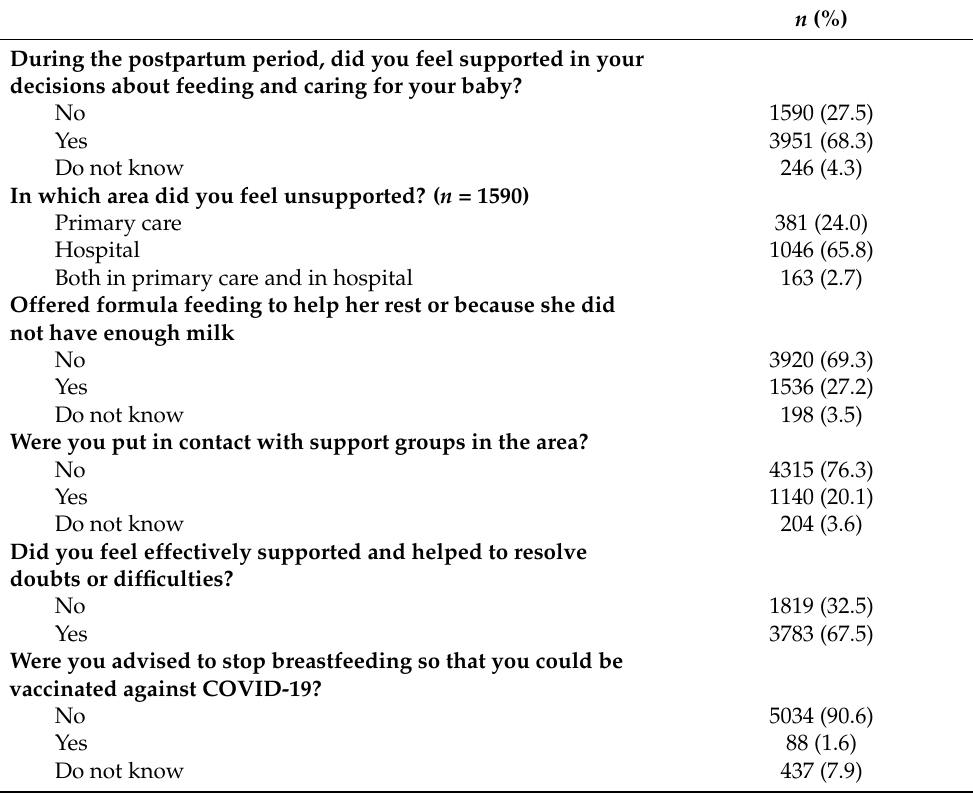
Table 2. Descriptive statistics of variables related to breastfeeding and obstetric violence ( n = 6060).